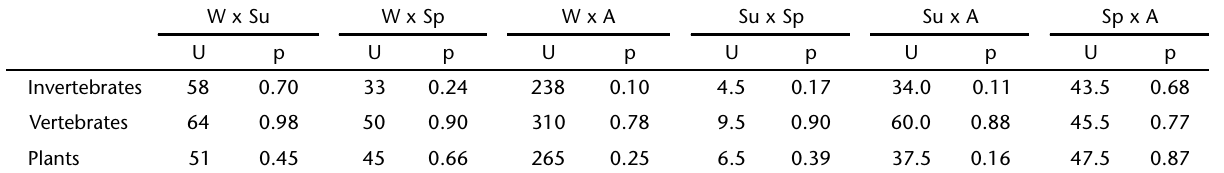
Table II. Mann-Whitney’s test results, indicating no significant differences (p > 0.05) in the prey abundance consumed with respect to the seasons: autumn (A), winter (W), spring (Sp) and summer (Su). W x Su W x